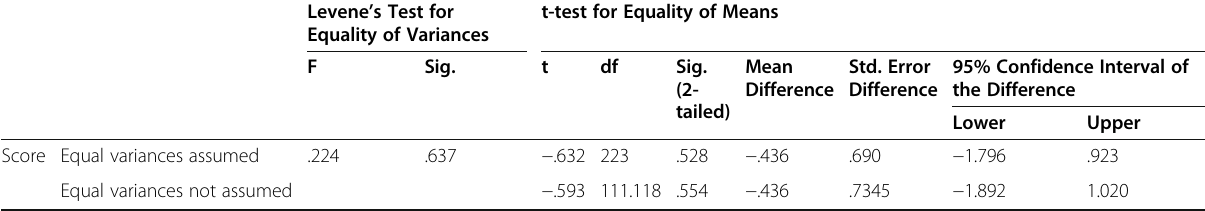
Table 8 Independent Samples t-Test on Bhutanese Science Teachers ’ Perceptions of the NOS Levene ’ s Test for t-test for Equality of Means Equality of Variances